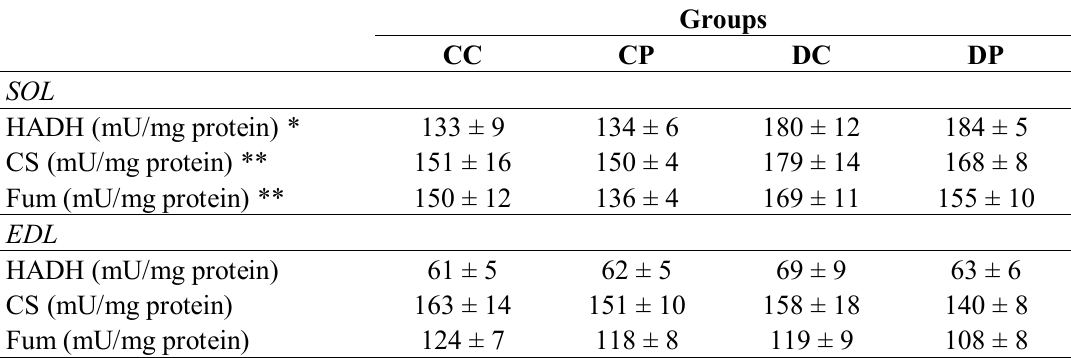
Table 1. Activities of oxidative metabolism enzymes in soleus (SOL) and extensor digitorum longus (EDL) muscles after 12 weeks of treatment (means ± SE).